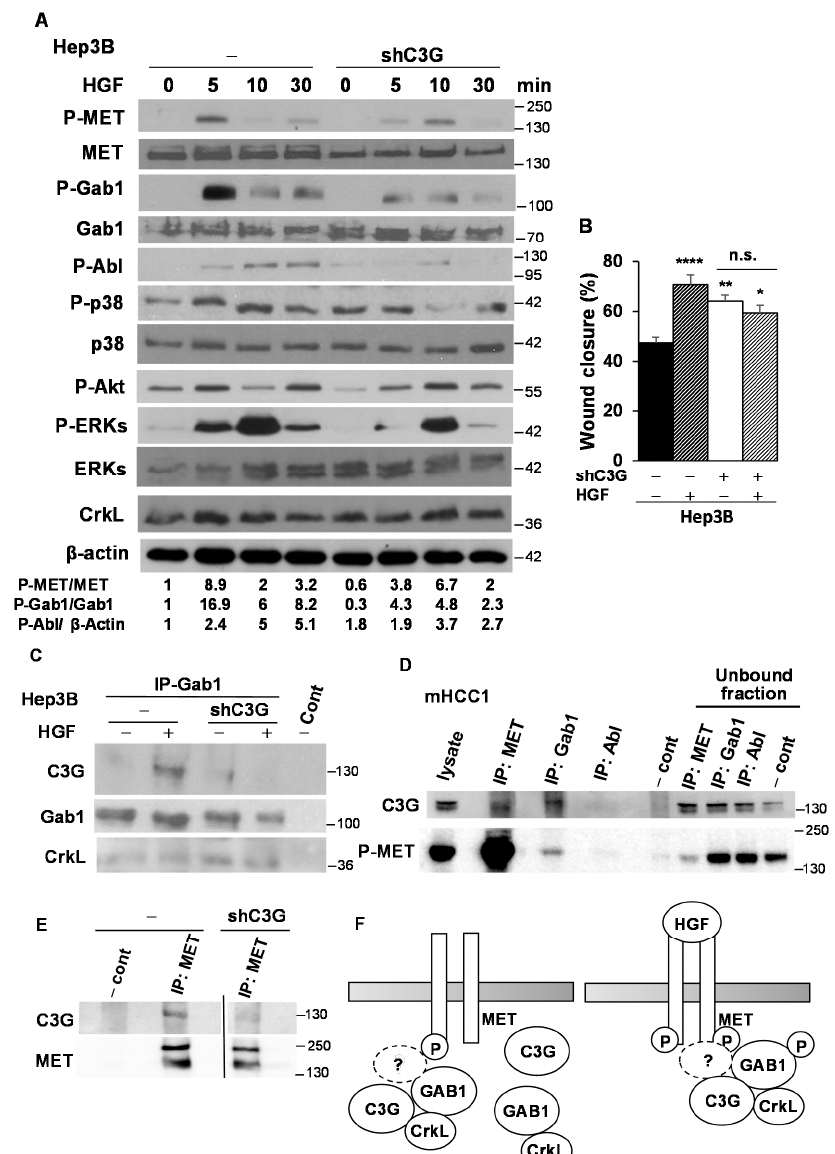
Figure 6. HGF / MET signaling is defective in C3G knock-down HCC cells. Hep3B (non-silenced ( − ) and C3G knock-down (shC3G)) were serum starved for 24h and stimulated with HGF. ( A ) Analysis of the activation of MET and its downstream e ff ectors after HGF stimulation at the indicated time points (min). Western-blot analysis of P-MET, MET, P-Gab1, Gab1, P-Abl, P-p38, p38, P-Akt, P-ERKs, ERKs, CrkL normalized with β -actin (P-Abl) or its corresponding total protein (P-MET and P-Gab1) levels, n = 3. ( B ) Wound healing assay. Histogram shows the mean ± S.E.M. of wound closure in cells maintained in the absence of serum, untreated or treated with HGF for 24 h. Two-way ANOVA followed by multiple comparison, * p ≤ 0.05, ** p ≤ 0.01, *** p ≤ 0.001, n ≥ 3. ( C ) Immunoprecipitation of Gab1 (IP-Gab1) in Hep3B lysates and western-blot analysis of C3G, Gab1 and CrkL in untreated or HGF (5min) treated cells ( n = 4). ( D ) Immunoprecipitation of MET (IP: MET), Gab1 (IP: Gab1) and Abl (IP: Abl) from lysates of mouse Alb-R26 Met mHCC1 cells, followed by western-blot analysis of C3G and P-MET (Y1234 / Y1235) in IPs and in the unbound fraction ( n = 2). ( E ) Immunoprecipitation of MET (IP: MET) in lysates from mHCC1 control ( − ) or shC3G silenced (shC3G) cells, followed by western-blot analysis of C3G and MET. As a negative control, sepharose beads were incubated with lysates in C – E . ( F ) Scheme showing the complexes formed in untreated (Left) or HGF treated cells (Right). MET can bind C3G when phosphorylated in a ligand independent